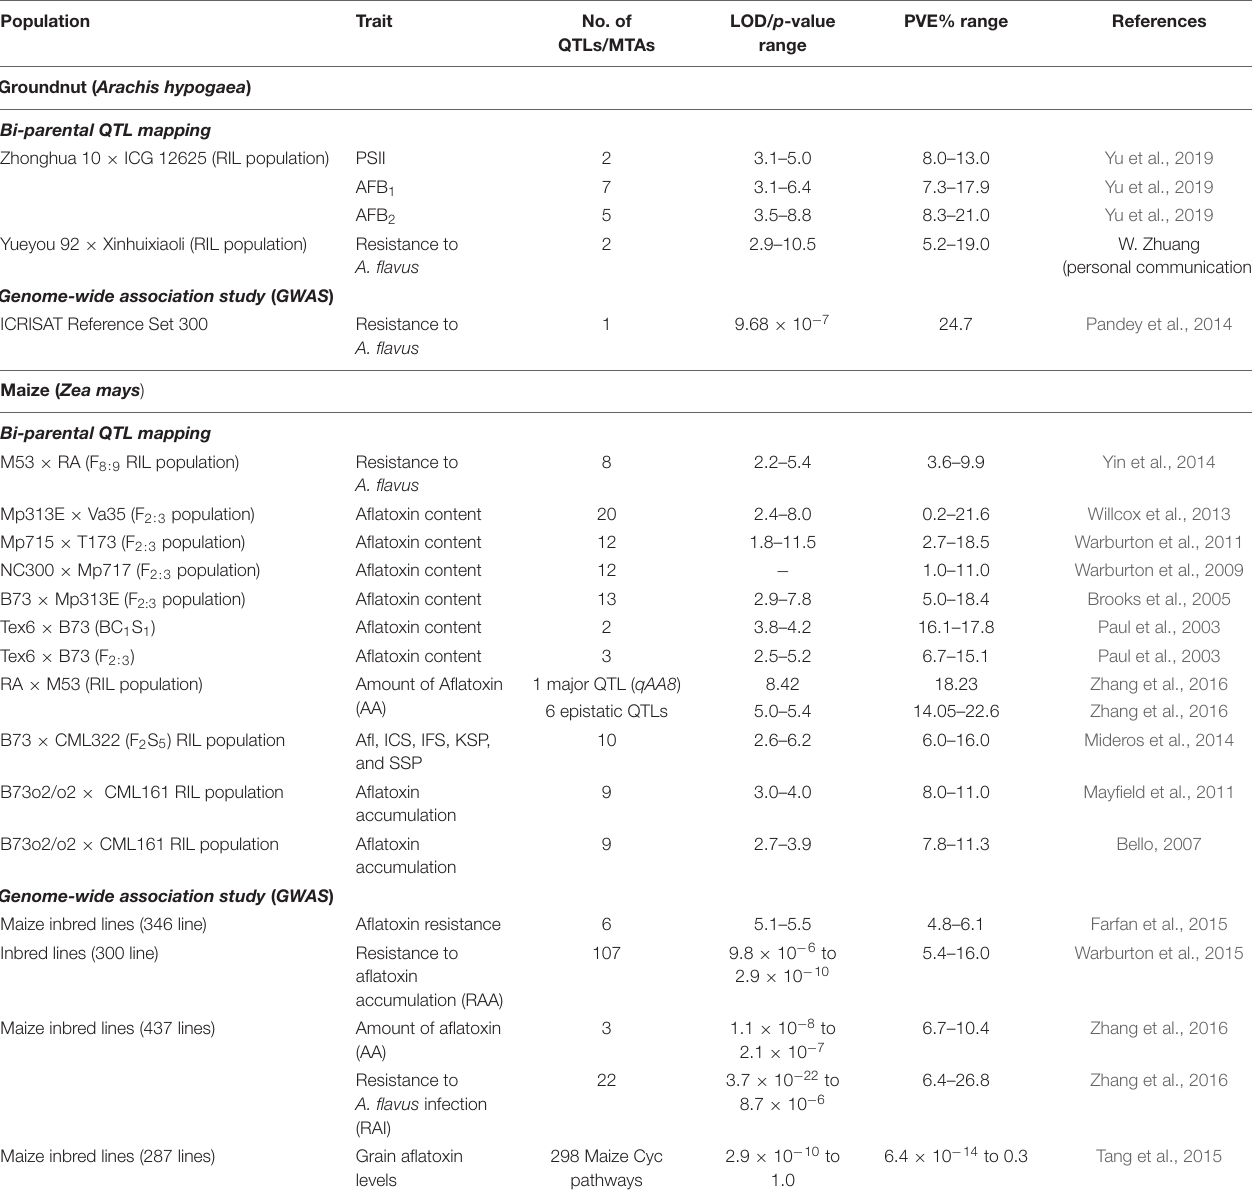
TABLE 1 | Key bi-parental QTL mapping and GWAS studies for discovery of genomic regions controlling aflatoxin contamination in groundnut and maize. Population Trait No. of